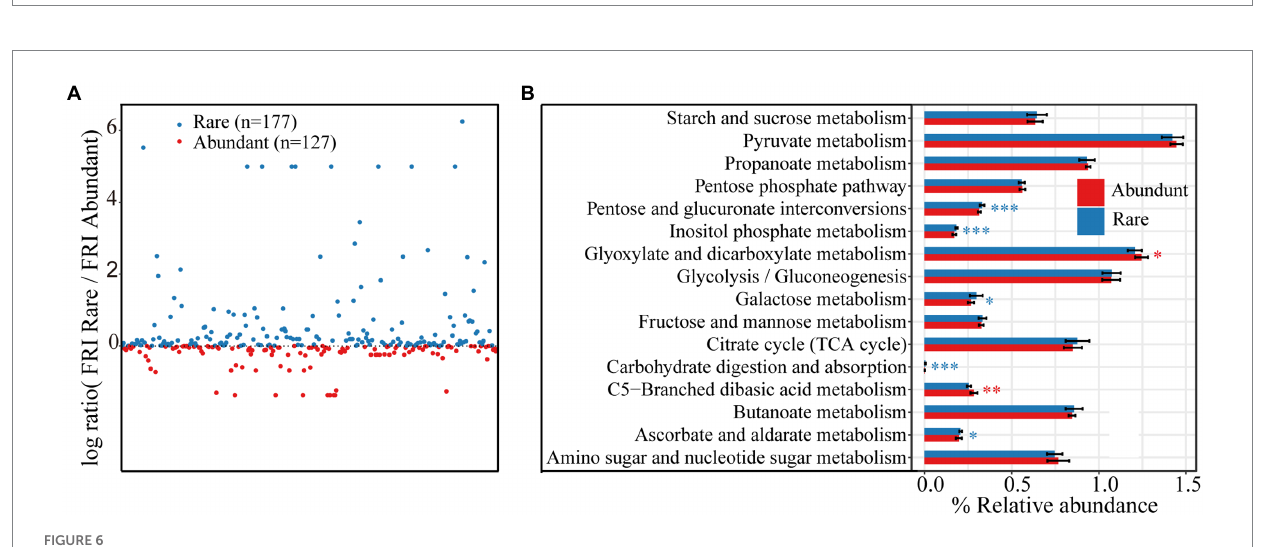
FIGURE 6 (A) Functional redundancy of rare and abundant taxa at KEGG pathway level 3. (B) Differences in functional redundancy among 16 carbon decomposition functions between rare and abundant bacteria. Asterisks indicate significance ( * p < 0.05; ** p < 0.01; *** p <